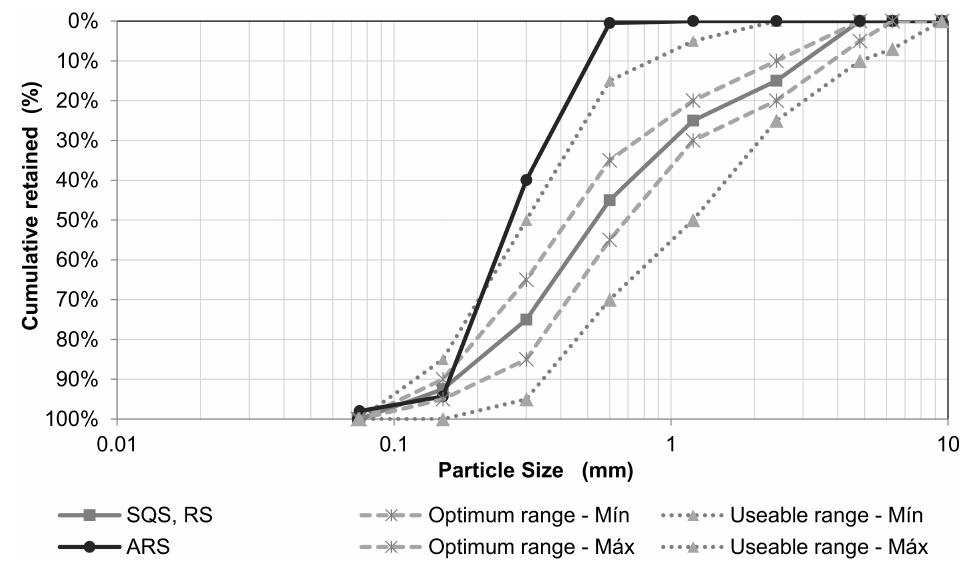
Figure 6. Small aggregate size range.